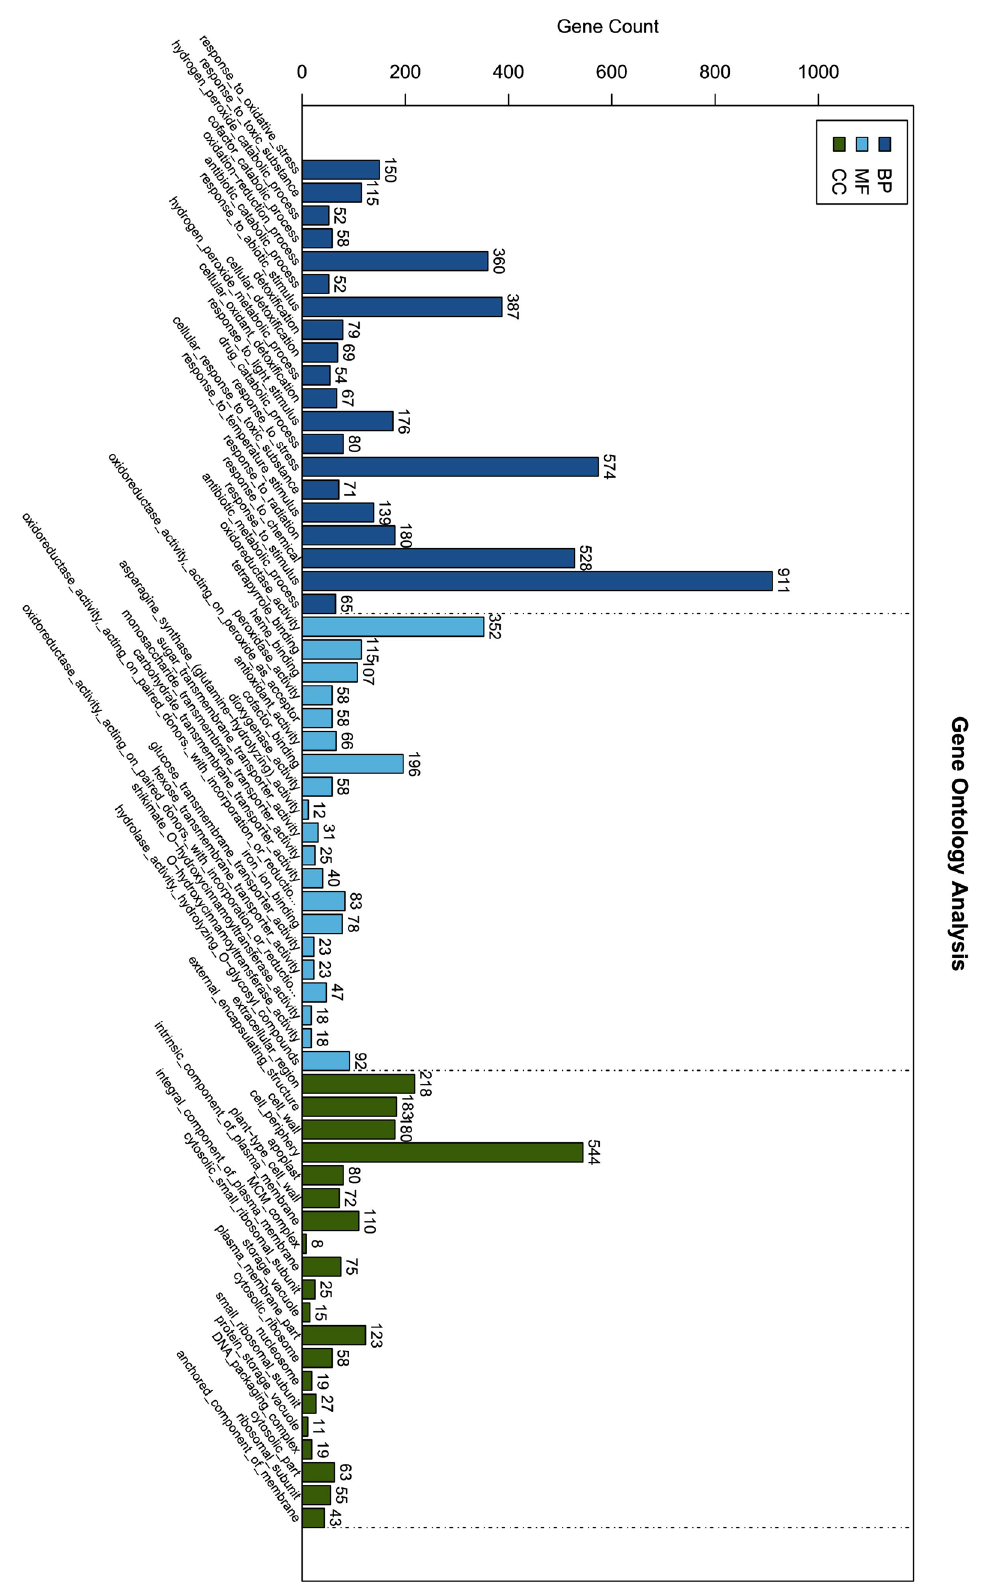
F igure 10. GO enrichment. Figure 10. GO